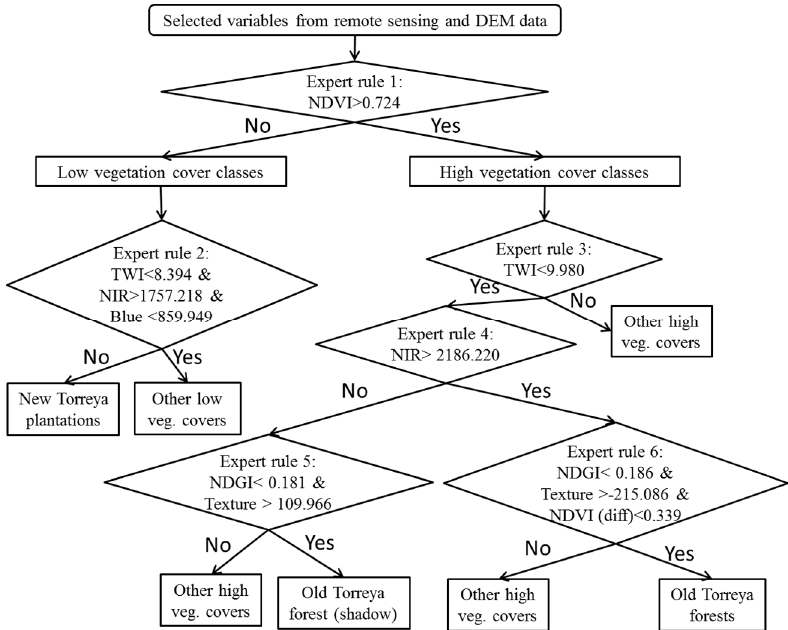
Figure 5. Extraction of old Torreya forests and new Torreya plantations using the expert rules-based approach (Note: NDVI(diff) = NDVI(GF) − NDVI(ZY); texture selected in this research is the textural image from PC1 using mean measure and window size of 11 x 11 pixels; NDVI and NDGI represent normalized difference vegetation index, and normalized difference greenness index, respectively; TWI represents topographic wetness index; DEM represents digital elevation model; NIR represents near infrared wavelength; and veg. represents vegetation).